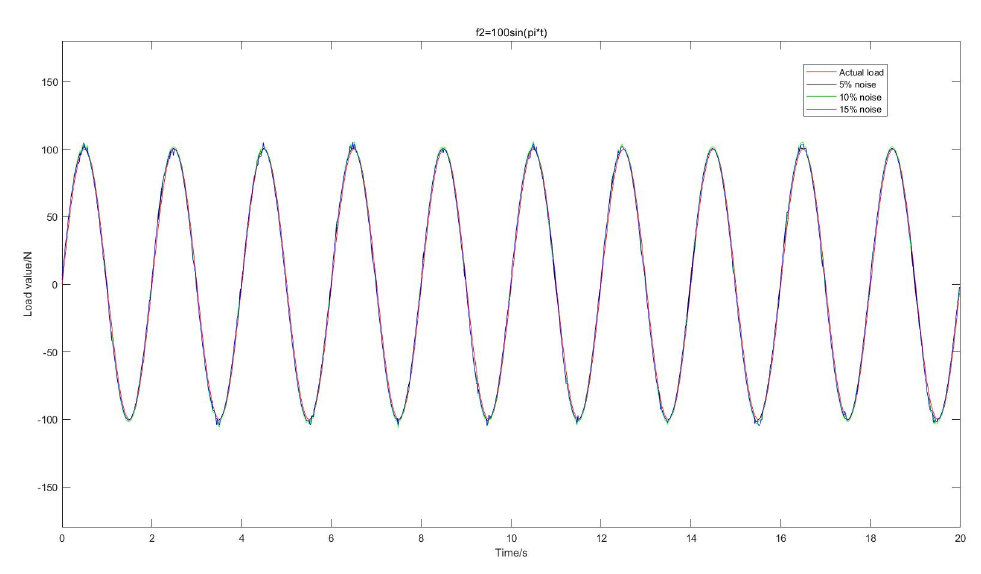
Figure 11. f 2 load identification with different noise levels. Table 1. Load identification errors with different noise levels.